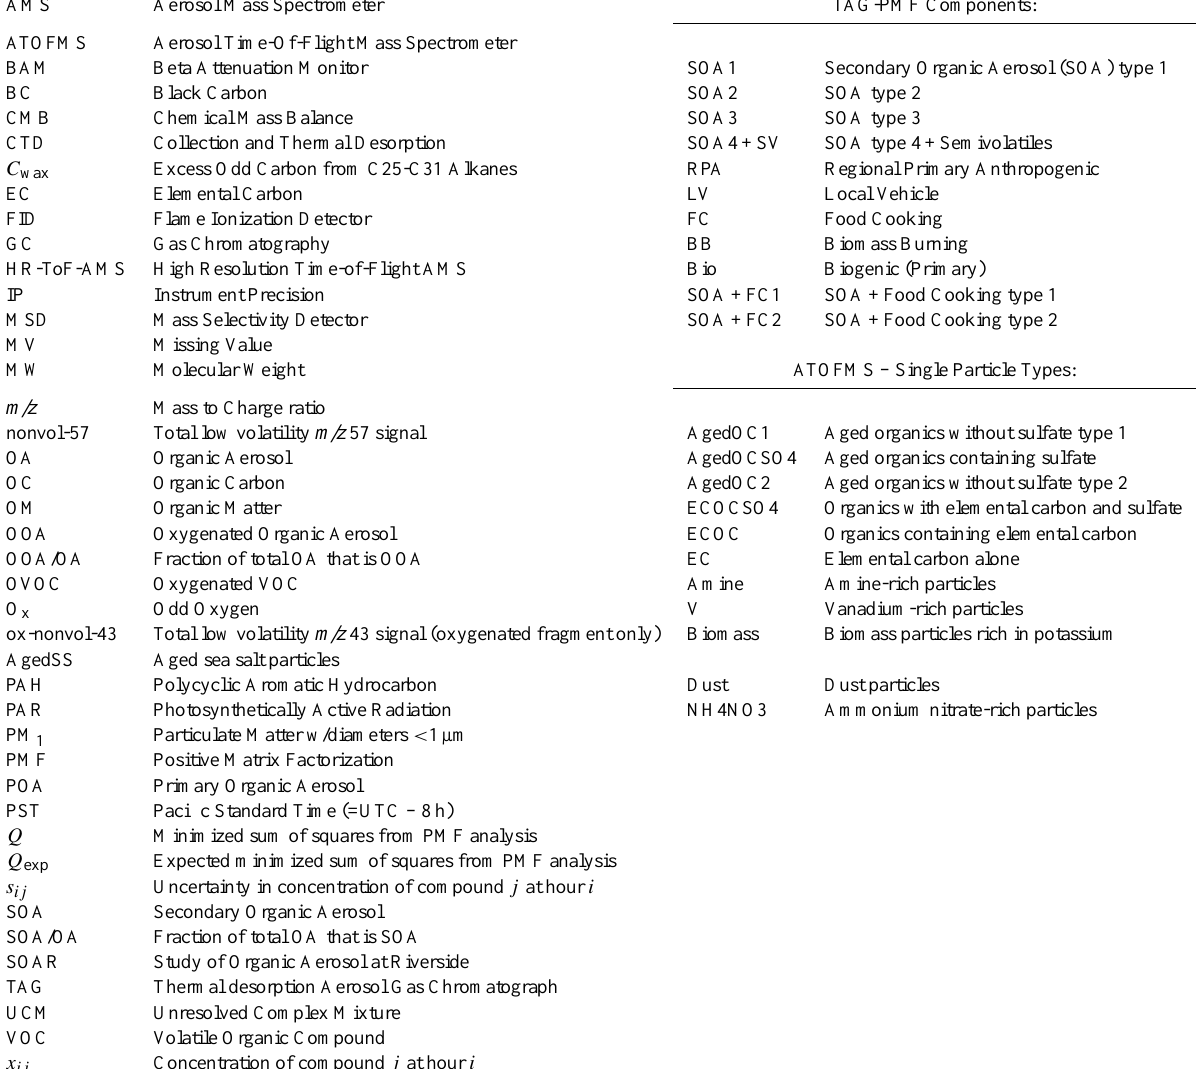
Table 1. List of Abbreviations used in this